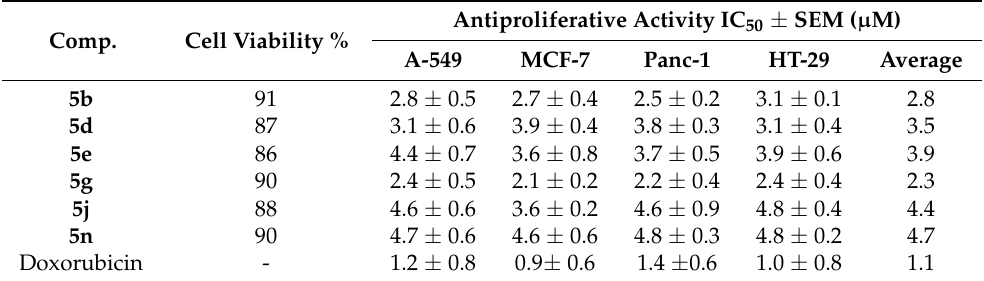
Table 2. Antiproliferative activity of compounds 5b , 5d , 5e , 5g , 5j , 5n and Doxorubicin.